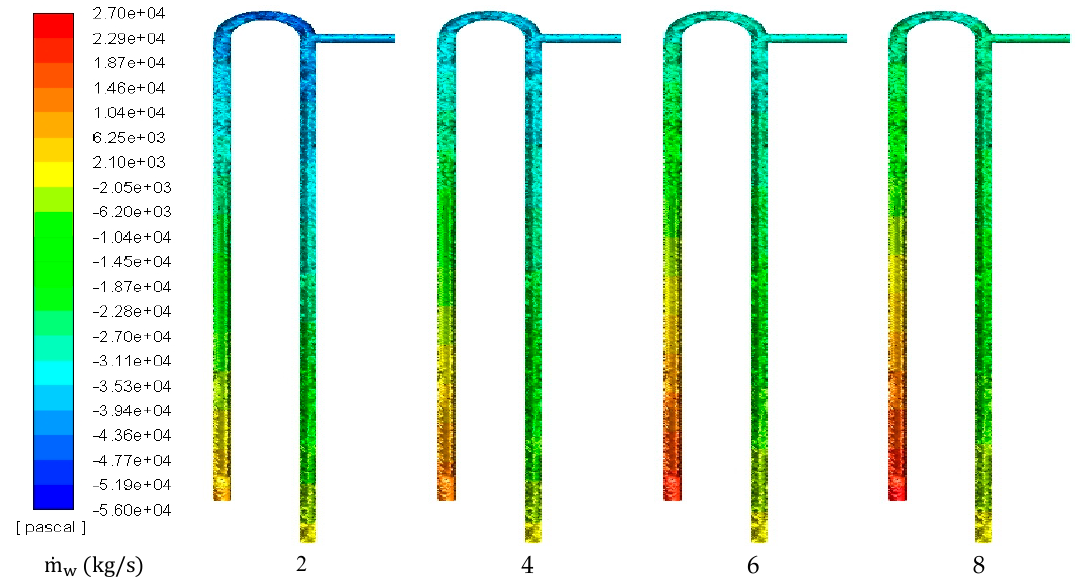
Figure 14. Pressure contours at different flow ratios and X (cid:2933) = 662.96, α (cid:2923) = 0.7 and X (cid:2932) = 0.5 .